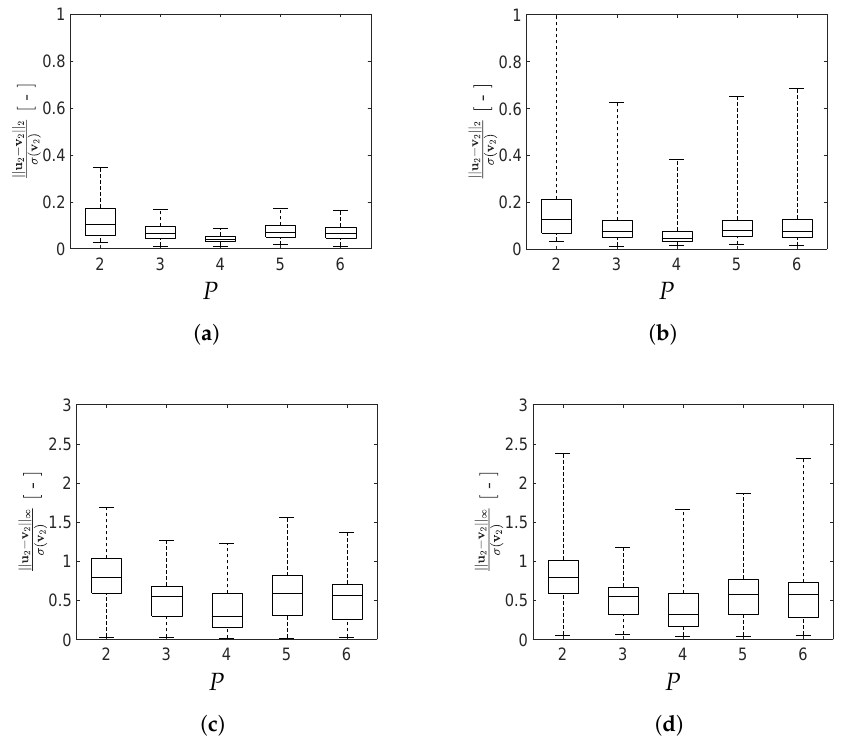
Figure 16. Two-storey shear building, configuration A. Effect of P on the statistics of the recon- struction errors relevant to the floor displacement v 2 , represented through box plots: ( top row ) standardized L 2 norm, and ( bottom row ) standardized L ∞ norm; data taken from ( left column ) training set, and ( right column ) test